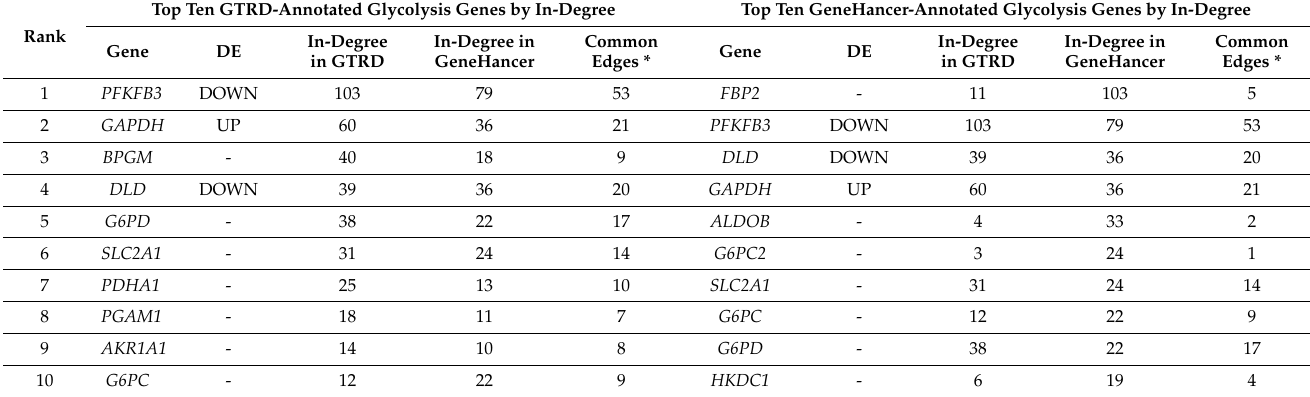
Table 16. Top ten target genes in GTRD- and GeneHancer-annotated transcription factor–target gene network of untreated RA CD8 + Tem